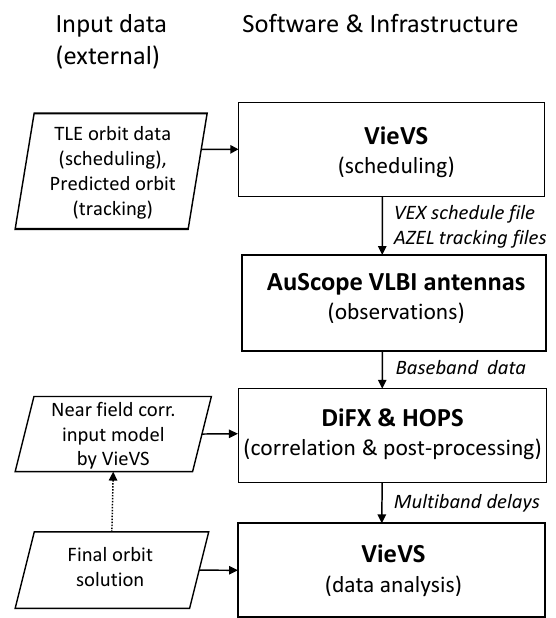
Figure 1. Simplified experiment work flow diagram illustrating the external input data (rhomboid boxes, left), the used software and infrastructure (rectangular boxes, right), and the essential interchange data (italic text).